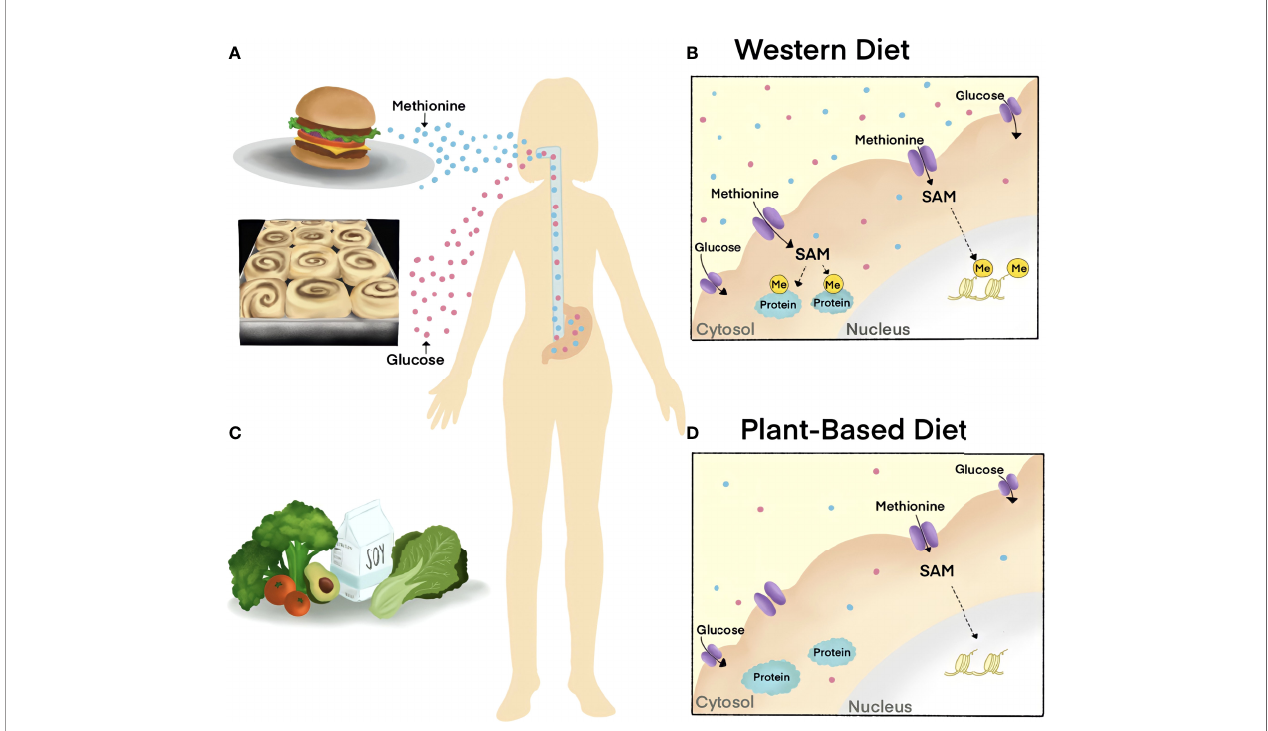
FIGURE 4 | The impact of diet on cellular metabolite abundance and molecular signaling cascades. (A, B) Western diets are rich in Methionine and sugar, metabolites that are related to the progression of disease. Excessive dietary Methionine contributes to elevated levels of substrate methylation in the nucleus (histone, yellow) and cytoplasm (proteins, blue) as SAM is the universal methyl-donor of the cell. (C, D) Diets low in Methionine, such as plant-based diets, decrease cellular methylation by reducing SAM. The World Health Organization recommends a healthy diet that is low in salt and sugar, high in fruits and vegetables, and that incorporates unsaturated fats (such as in avocado) over saturated fats (such as in fatty